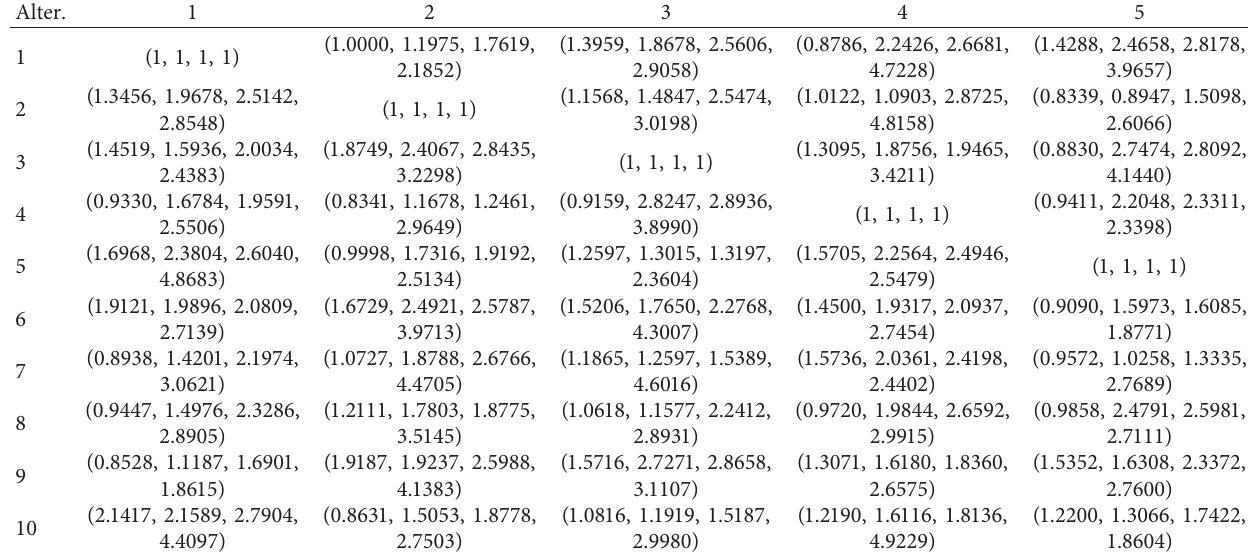
(part 1: columns 1–5). URL